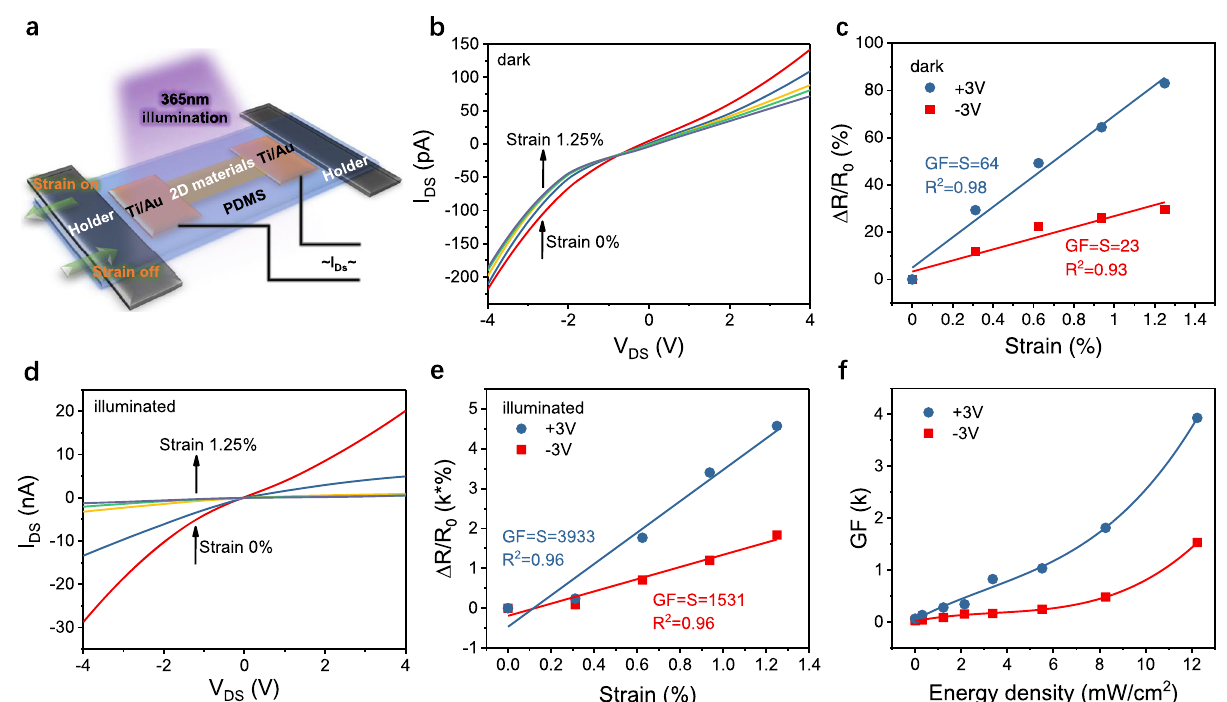
Fig. 1 Giant gauge factor (GF) of SnS 2 based strain sensors. a Schematic of the Van der Waals strain sensor devices. b I – V curves under various strain conditions measured in darkness. c The variation of Δ R = R 0 as a function of strain for the sensor measured in darkness. d I – V curves under various strain conditions measured with 365 nm light illumination. e The function of Δ R = R 0 versus strain of the sensor measured under 365 nm illumination. f GF value of the strain sensor as a function of the power density of 365 nm